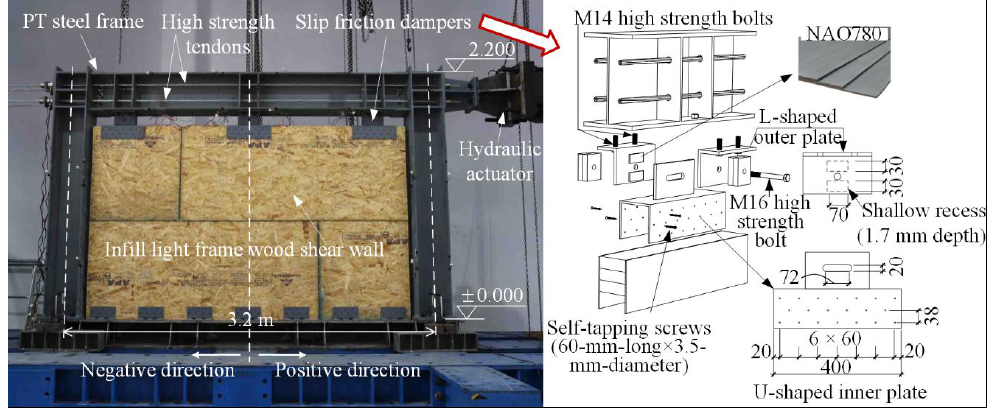
Figure 2. Configuration of the specimen.